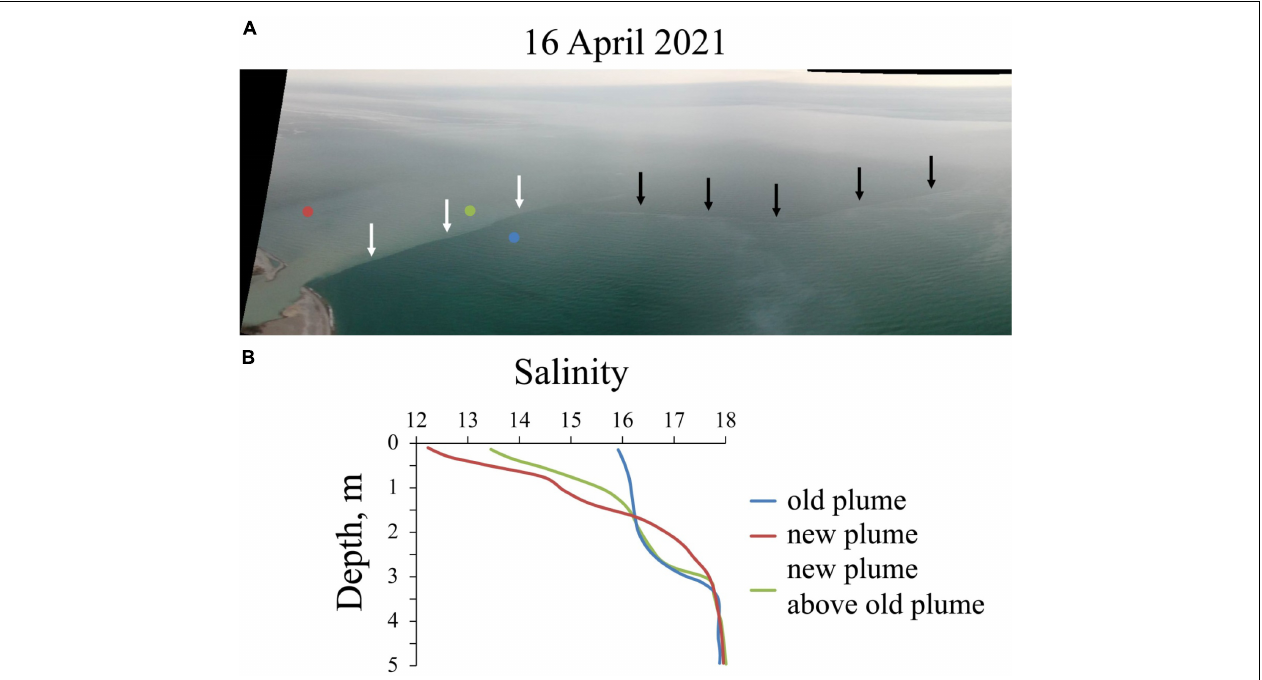
FIGURE 5 | Aerial panoramic image (A) and vertical salinity structure (B) of the near-field (new plume) and outer (old plume) parts of the Bzyb plume shortly after the plume reversal acquired on 16 April 2021 at 15:15. Colored dots in panel (A) indicate locations of vertical salinity measurements. White arrows indicate location of the border between the new plume and the old plume, black arrows indicate location of the border between the old plume and the ambient sea.